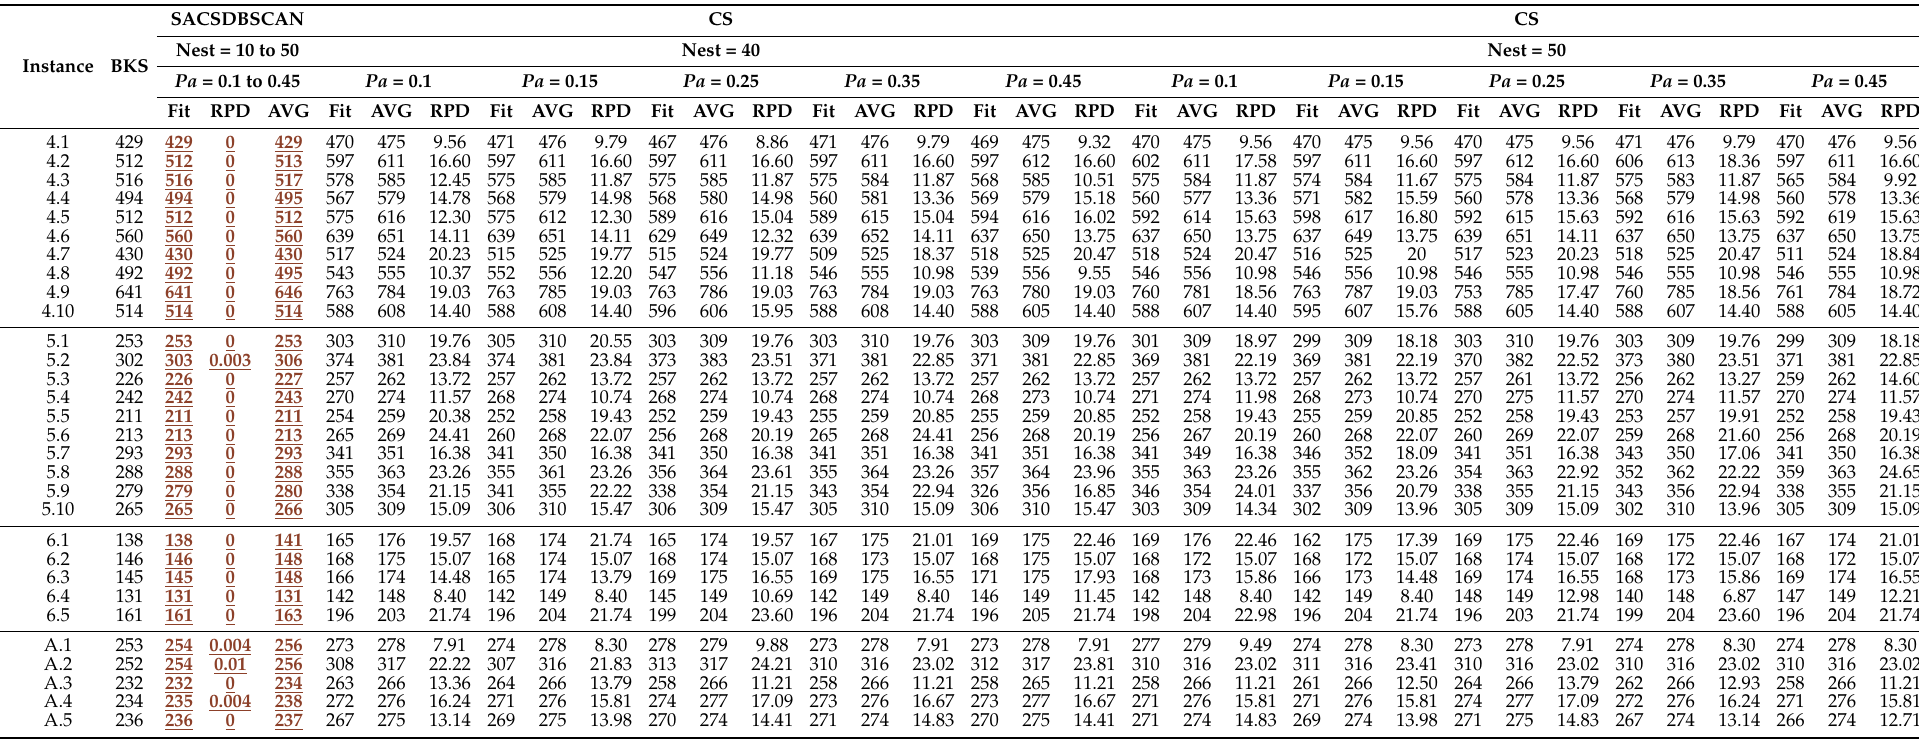
Table 7. Comparison results for set of groups 4, 5, 6, A. SACSDBSCAN v/s CS Nest = 40,